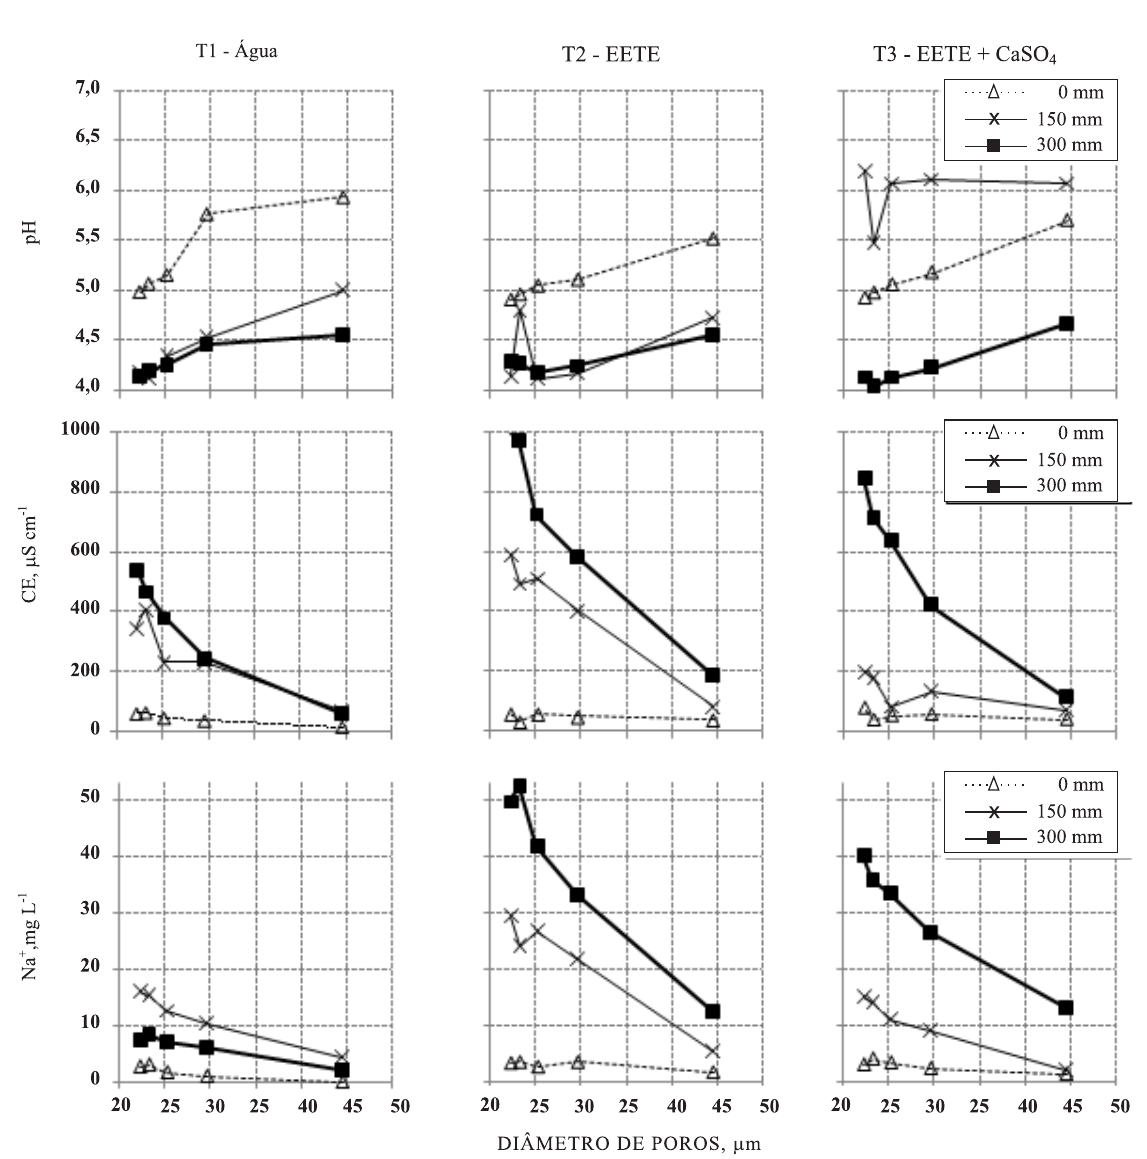
Figura 1. Valores de pH, condutividade elétrica (CE) e sódio na solução do solo em função do diâmetro de poro, no solo não irrigado (0 mm) e irrigado (150 e 300 mm) com água destilada (Tratamento 1), efluente de estação de tratamento de esgoto EETE (Tratamento 2) e EETE + CaSO